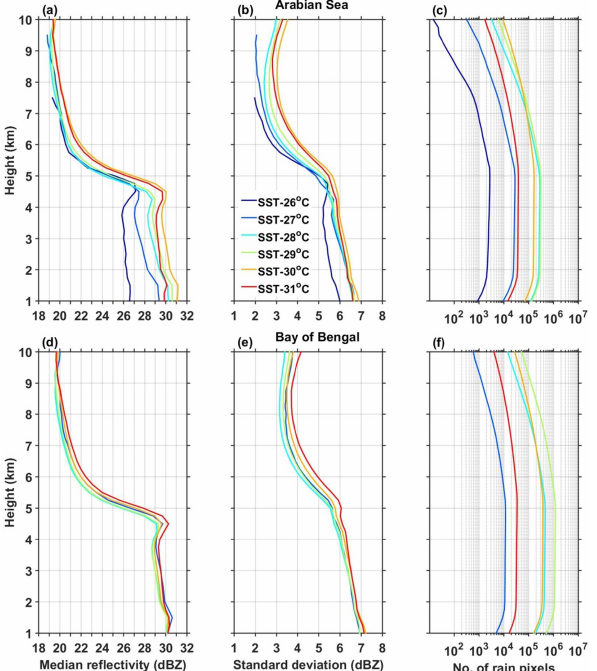
Figure 4. Same as Fig. 3 but for shallow precipitating